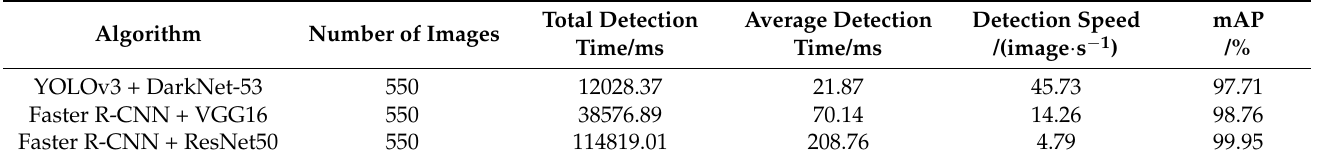
Table 3. Detection speed and precision rates of the different recognition methods.